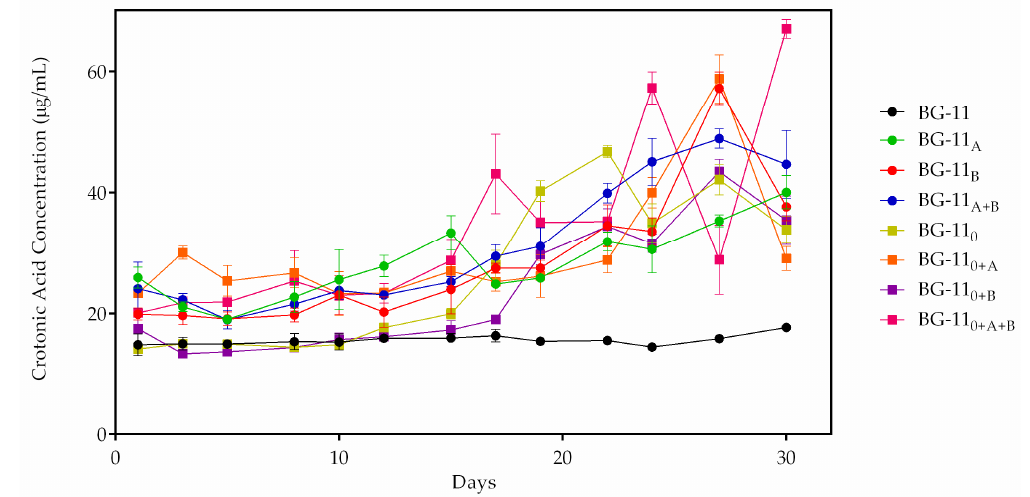
Figure 6. PHB in the form of crotonic acid of Stigeoclonium sp. B23 in 8 modified growth conditions. Data are the mean ± SD of three replicates.